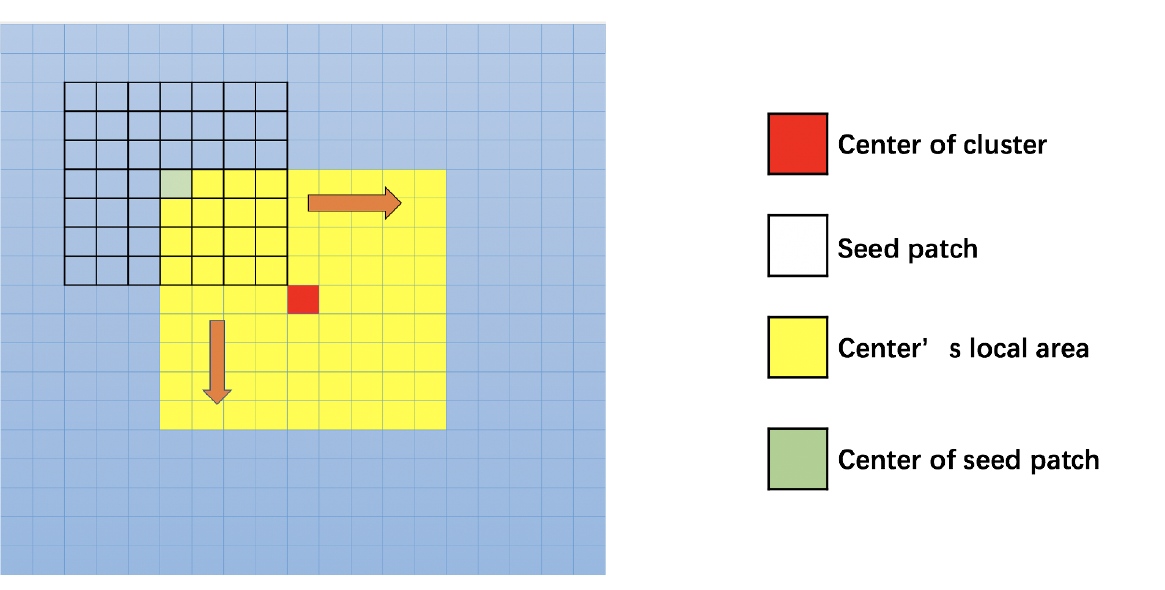
Figure 7. Find the seed patch with the highest